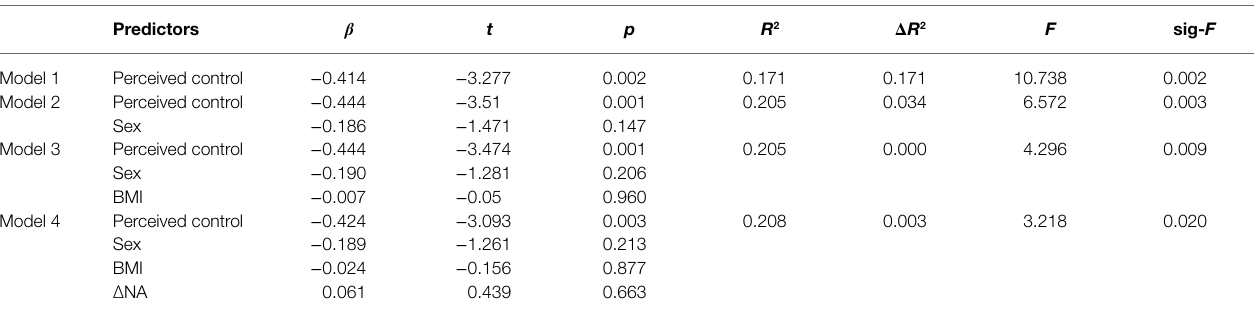
TABLE 1 | Hierarchical regression analyses on HPA axis response to the